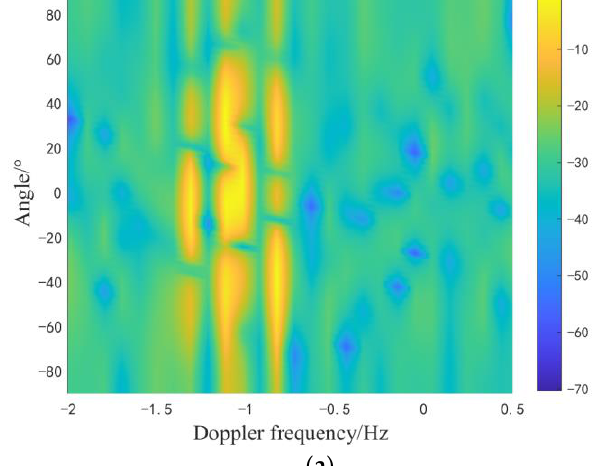
Table 2. Clutter components and target simulation parameters.